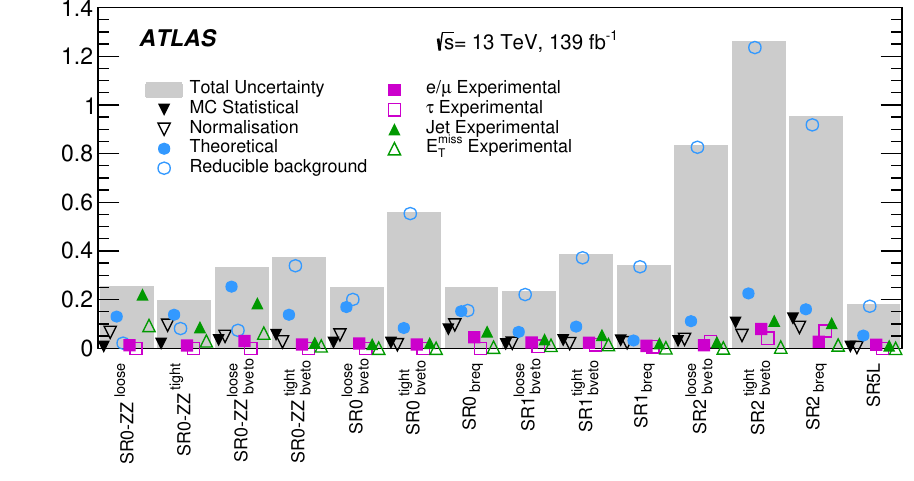
Figure 4. Breakdown of the dominant systematic uncertainties in the background estimates for the signal regions. Theoretical uncertainties in the simulation-based estimates, including those in the acceptance for events in ZZ and t ¯ tZ simulations, are grouped under the “Theoretical” category, while the “Normalisation” category includes the statistical uncertainties of the data counts in CRZZ and CRttZ and the uncertainty from the fitted normalisation factors. For simplicity, the individual uncertainties are added in quadrature for each category, without accounting for correlations. The total background uncertainty is taken from the background-only fit where correlations of individual uncertainties are accounted